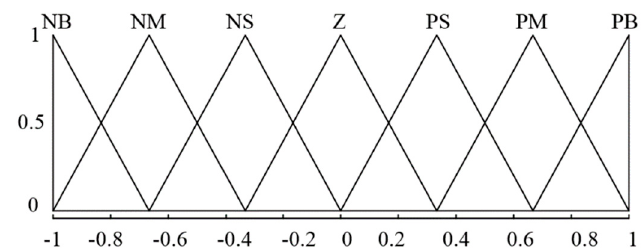
Figure 9. Membership functions of the inputs.